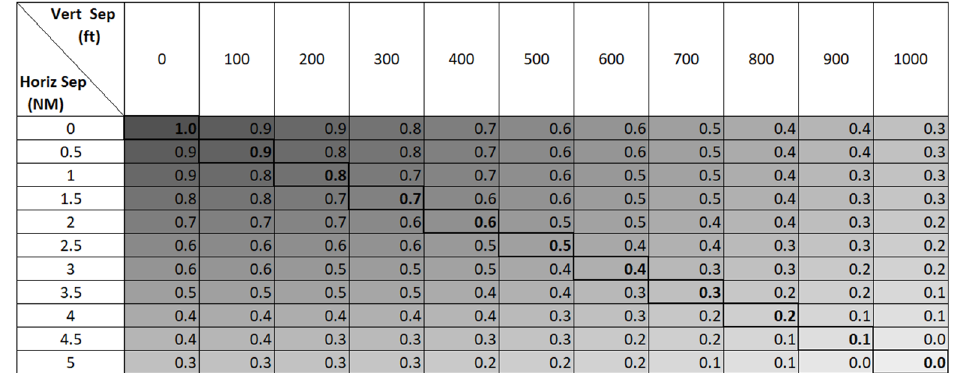
Figure 4. Oblique distance between interval ranges.